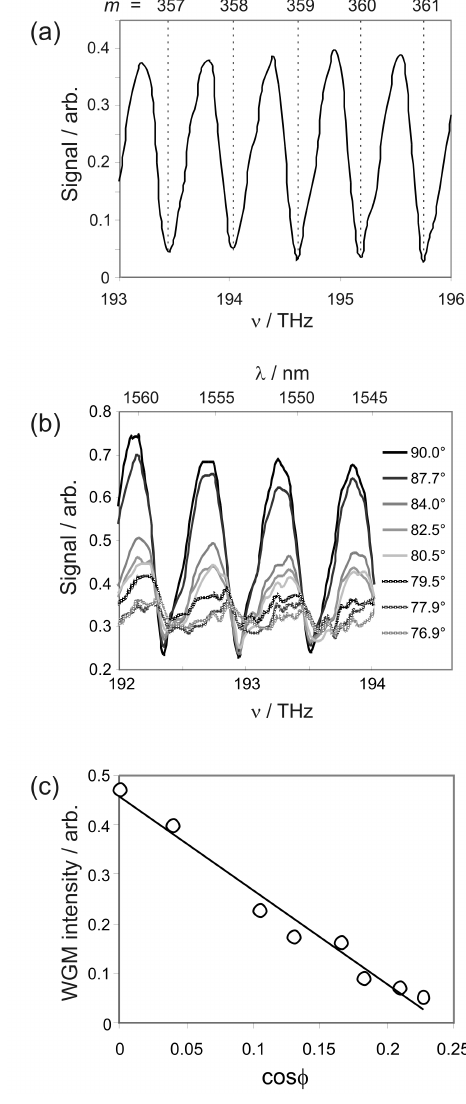
Figure 3. (a) Experimentally measured WGM spectrum for a 125 µ m diameter bare